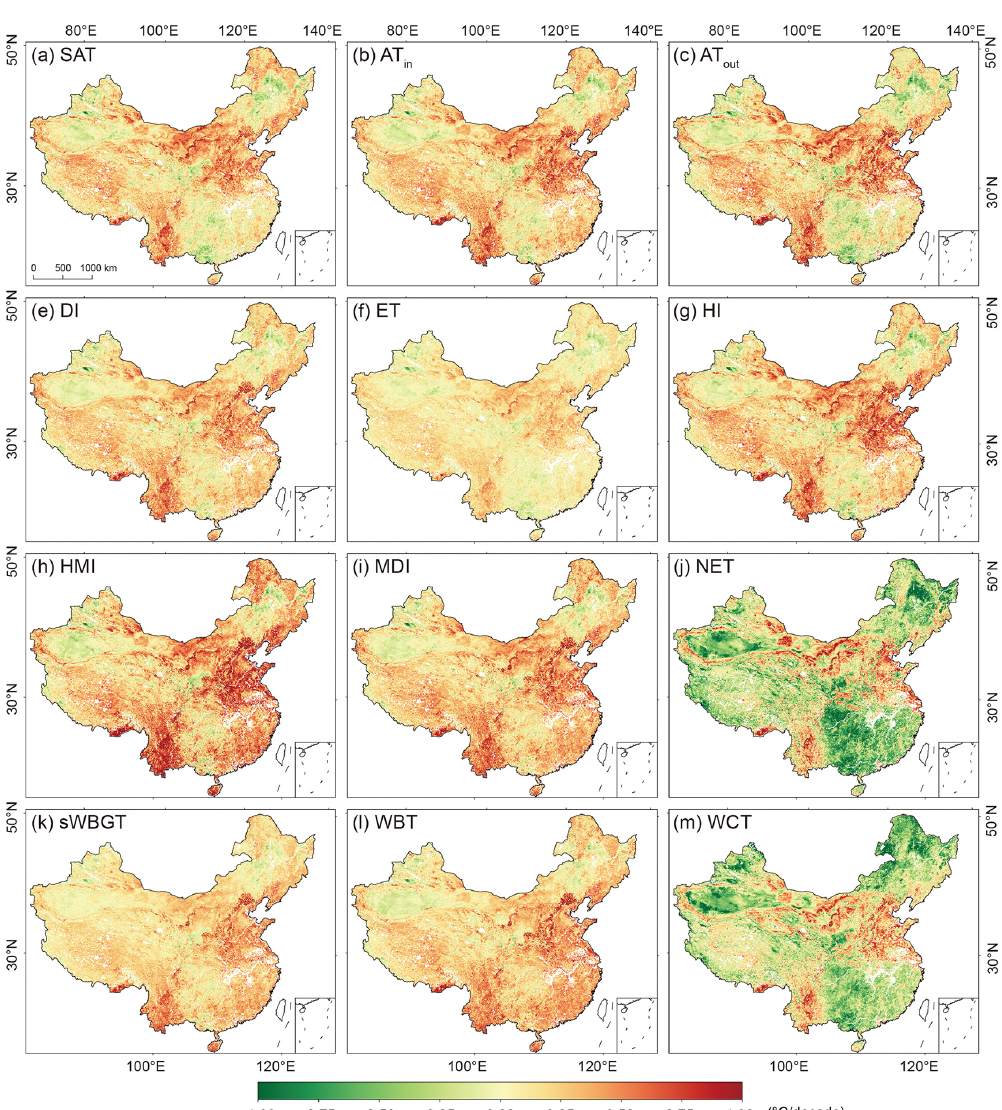
Figure 12. Spatial distributions of the linear trends (unit: ◦ C per decade) in the 12 annually averaged human thermal indices over the mainland of China during